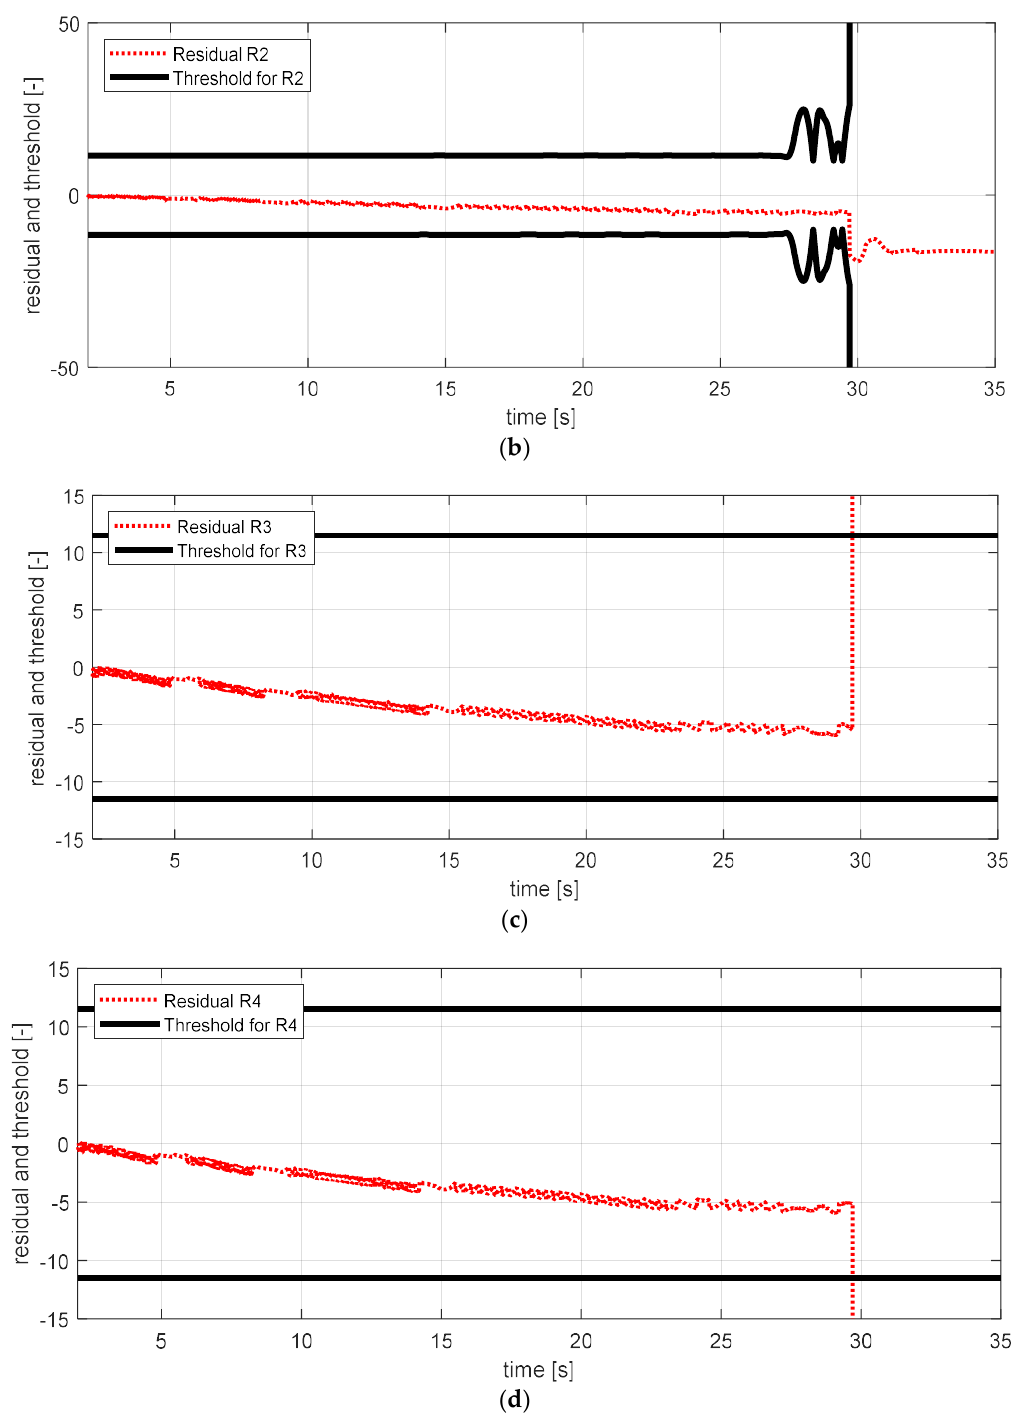
Figure 18. FDI simulation result for yaw rate sensor fault (fault). ( a ) Residual 1 and threshold; ( b ) residual 2 and threshold; ( c ) residual 3 and threshold; ( d ) residual 4 and threshold.